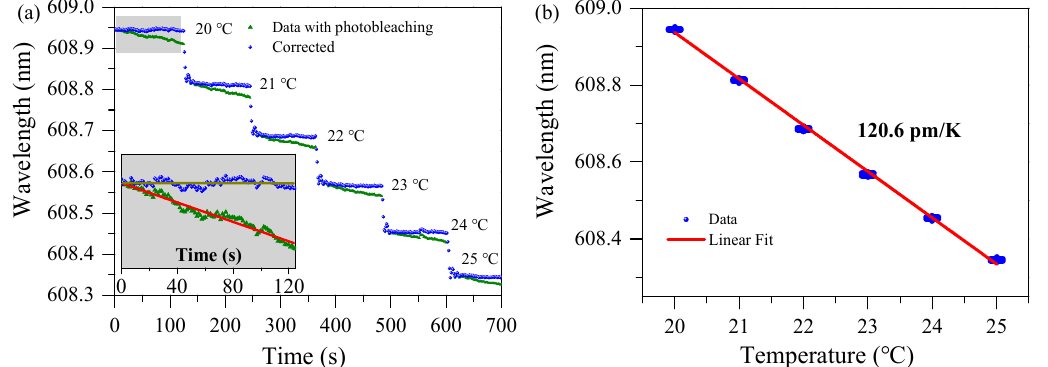
Figure 5. Temperature dependence of wavelengths of lasing mode. ( a ) Lasing emission wavelength shift with photobleaching and corrected data for photobleaching when changing the TEC temperature at a periodic interval. Inset shows the enlarged view at 20 °C. Brown and red line are the linear fitting curve. ( b ) Tracked laser wavelength with error bar vs temperature.